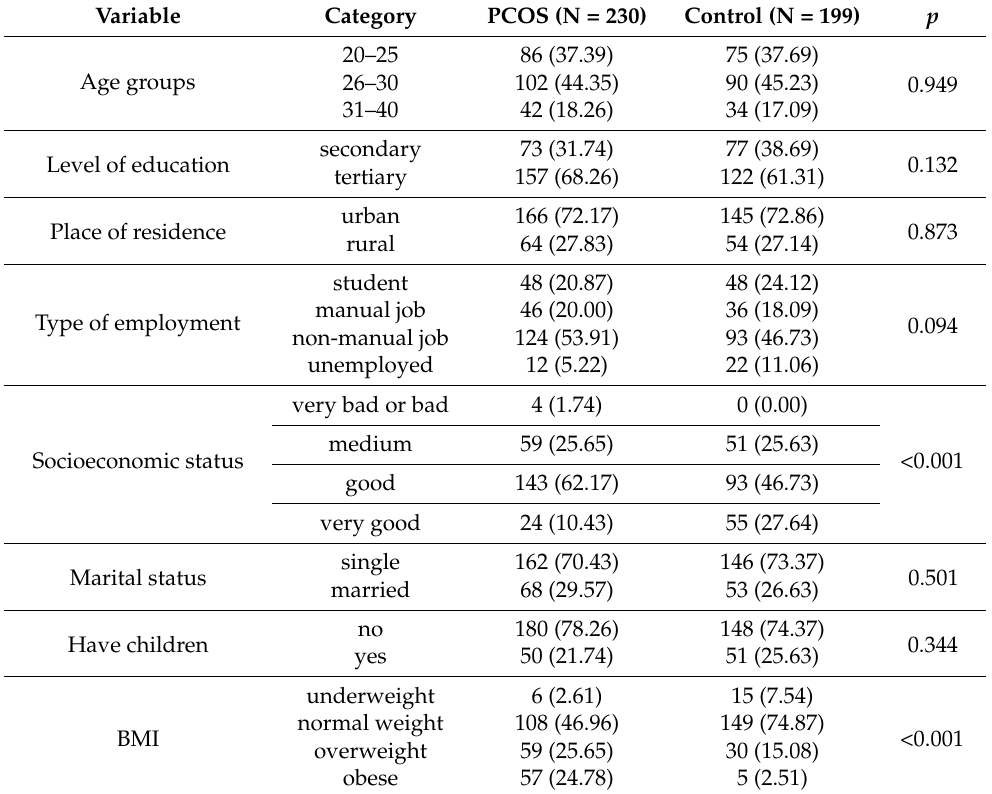
Results are presented as n (%). p for chi-square test.